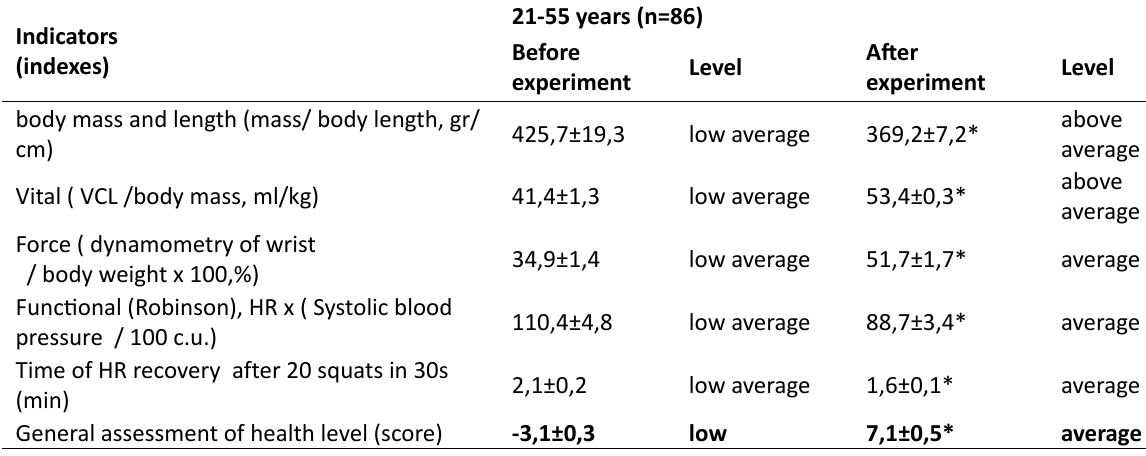
Table 4. Dynamics of indicators level of women physical (somatic) health ( Õ ±m) Indicators